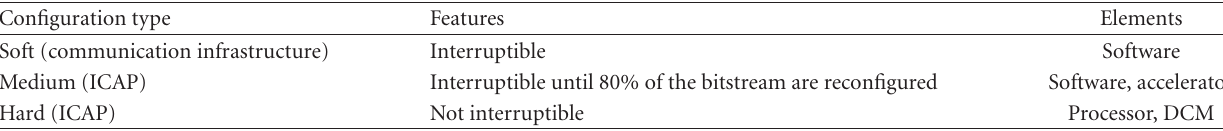
Table 2: Configuration types.